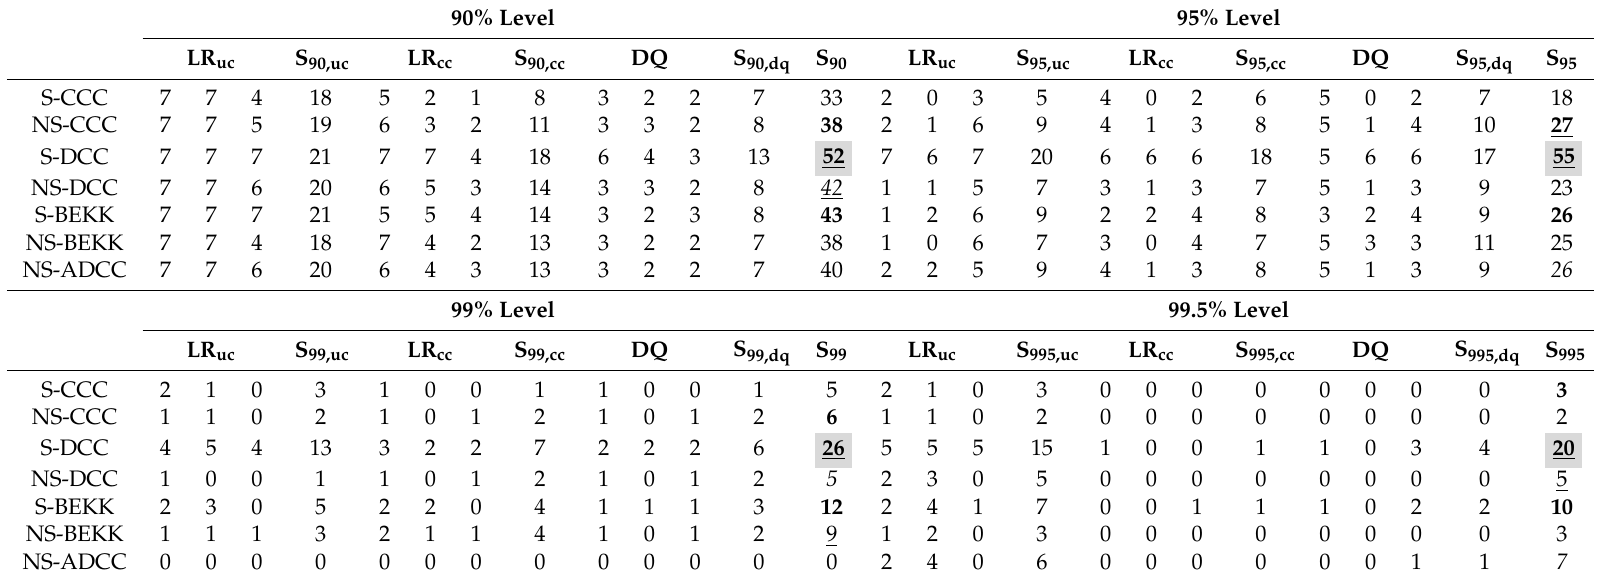
Table 7. The summary results for the out-of-sample VaR forecasts performance of equal-weight stock portfolios based on alternative accuracy